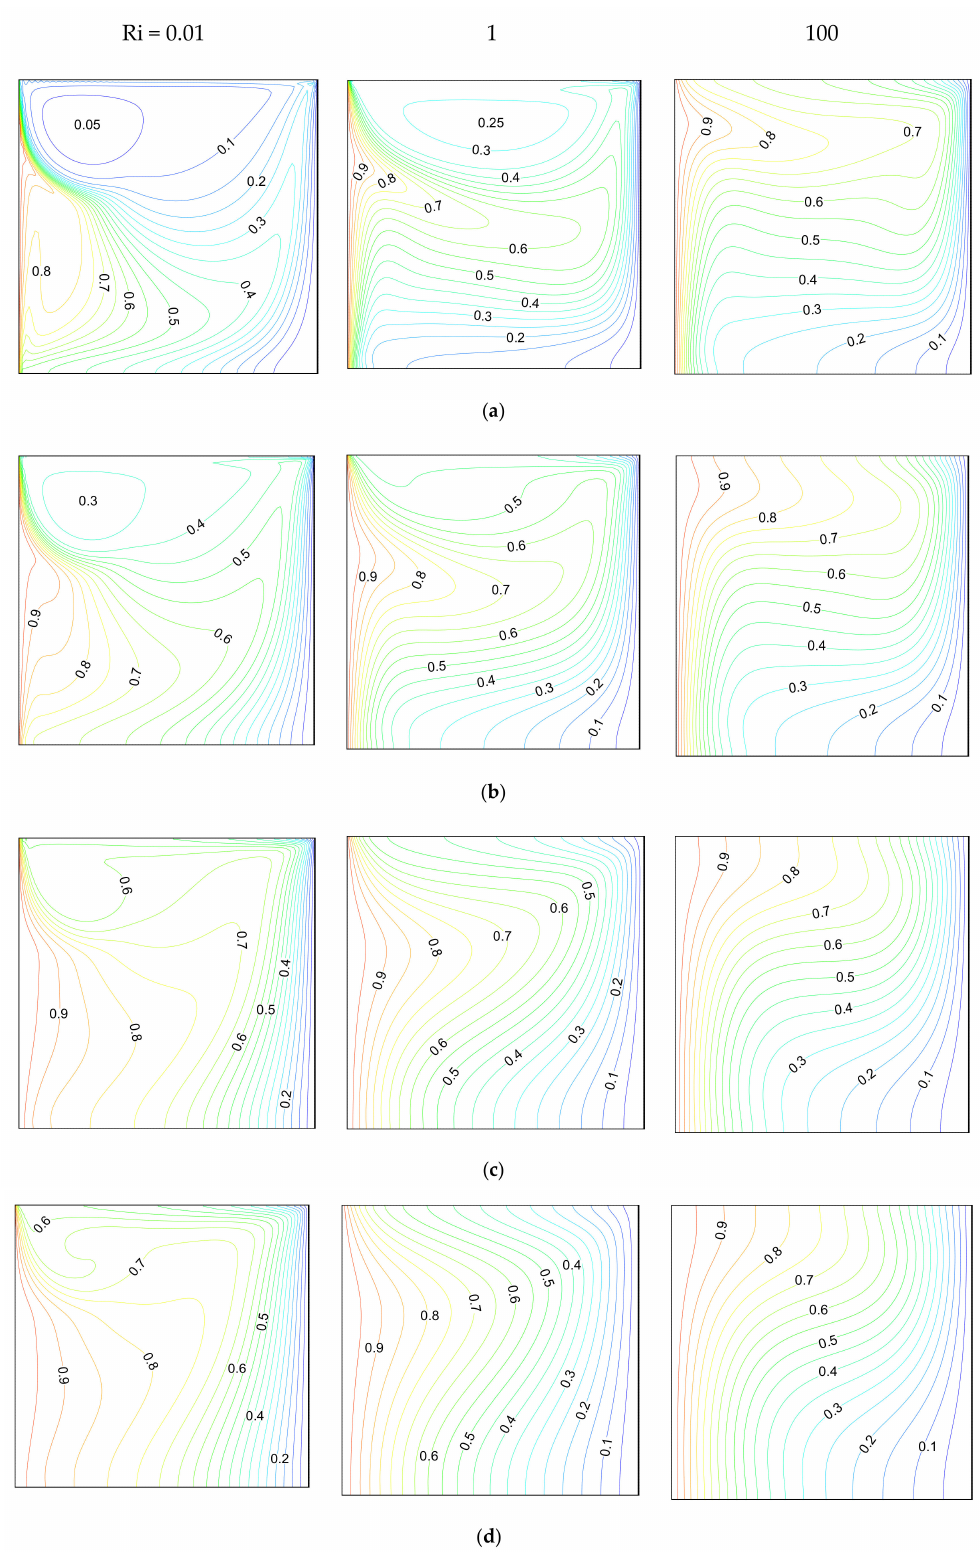
Figure 5. Isotherms for di ff erent Rd and Ri values with U 0 = − 1 (Case 2) and Φ = 0.02. ( a ) Rd = 0; ( b ) Rd = 1; ( c ) Rd = 5; ( d ) Rd =